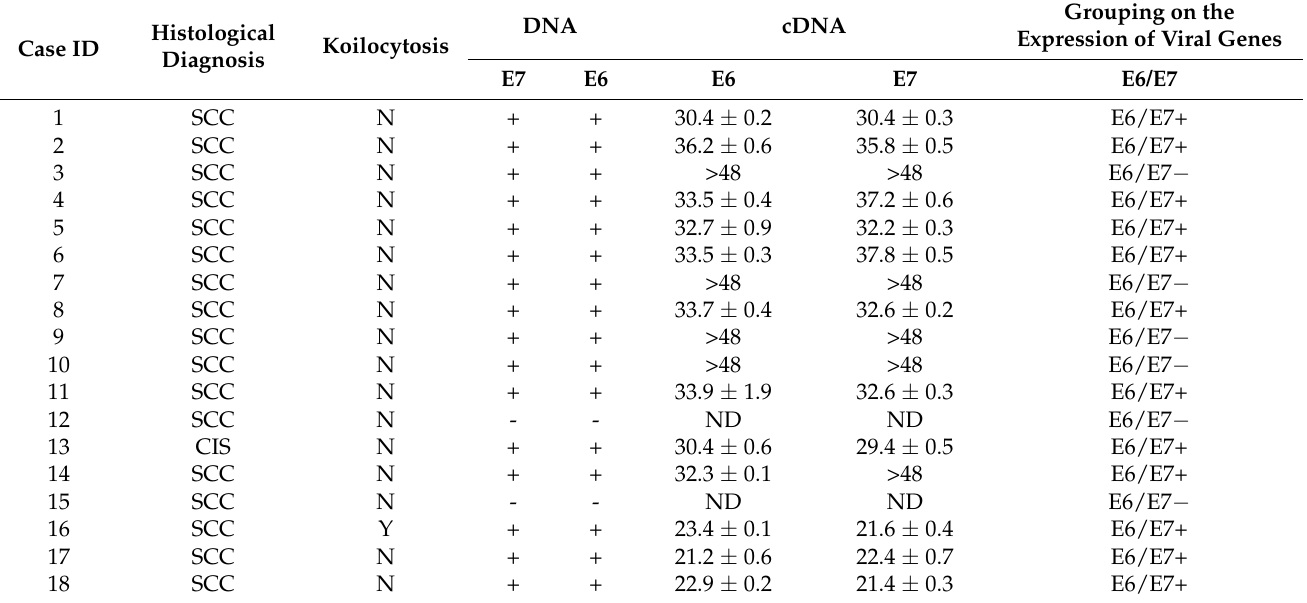
Table 1. Histological diagnosis, koilocytosis, EcPV2-E6 detection, and E6 / E7 gene